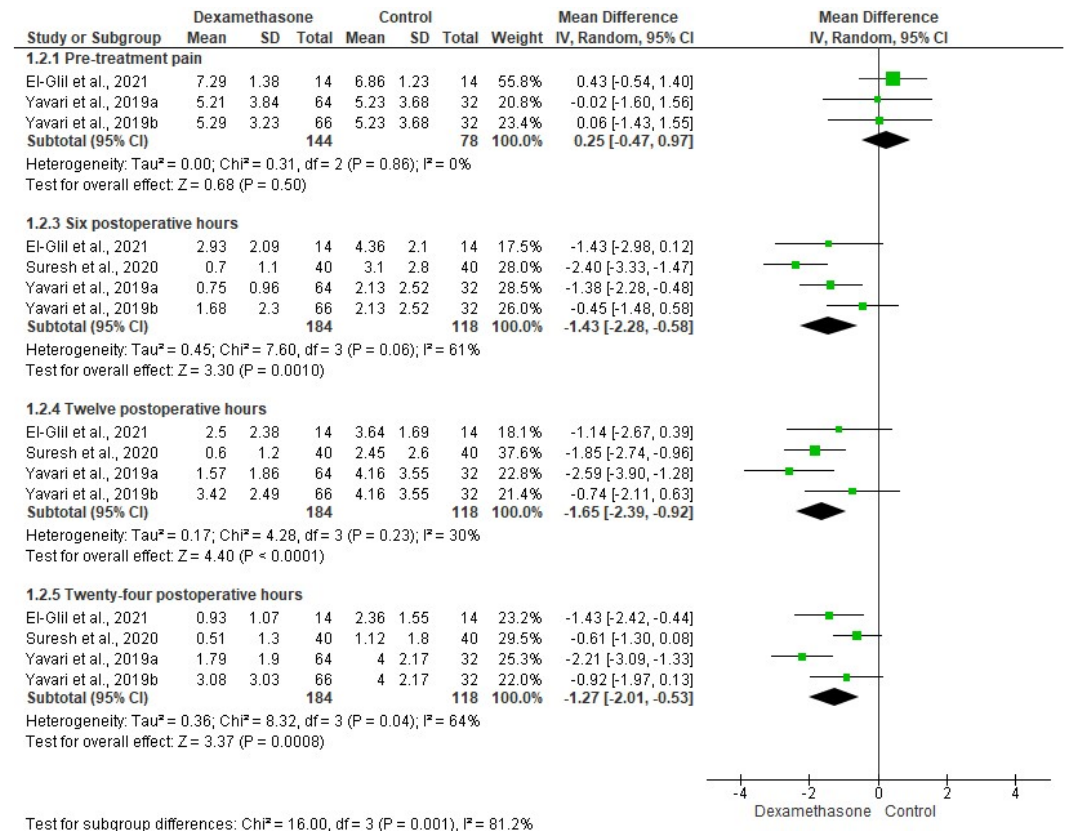
Figure 4. Meta-analysis of the pain intensity, by VAS ( p < 0.05) [15,22,23]. The number of patients who took rescue analgesics in the dexamethasone group was lower in comparison with controls, but a statistical difference was not found ( n = 58) [10,18]. On the other hand, the risk of adverse reactions was determined with data from five clinical assays ( n = 436) [9,11,14,20,22]. Only one patient in the dexamethasone group and no patients in the control group presented adverse effects. 3.4. The Sensitivity Evaluation and Publication Bias The sensitivity analysis did not show important changes in the results of either the anesthetic success index or the pain intensity meta-analyses. Moreover, the visual evalu- ation identified no publication bias using a funnel plot (Figure 5).